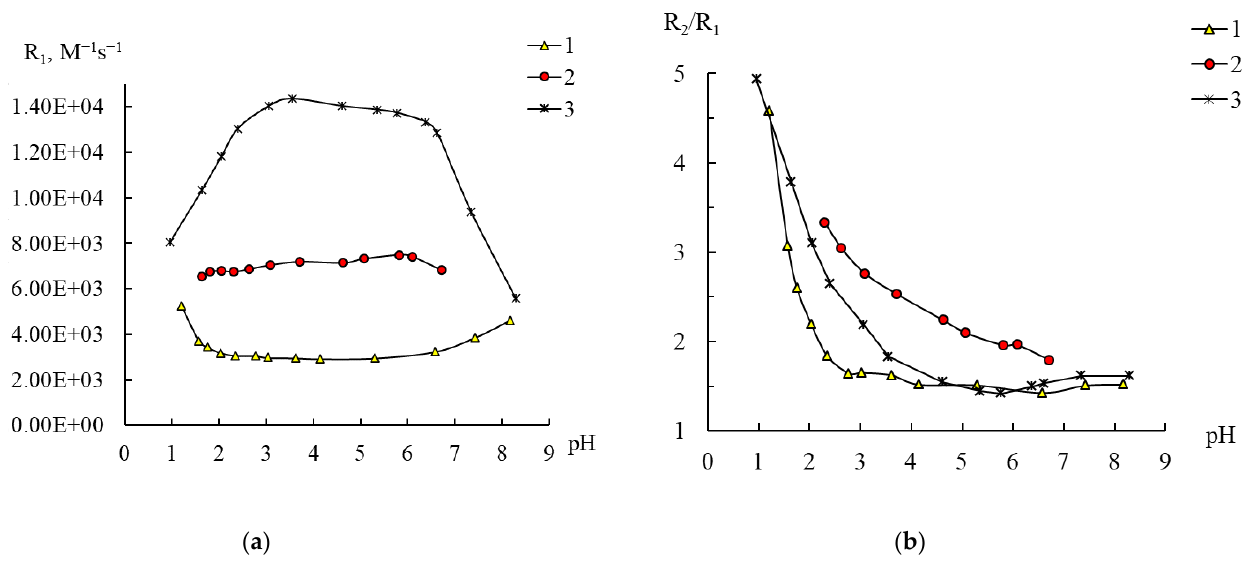
Figure 7. Changes in the relaxation efficiency R 1 ( a ) and the ratio R 2 /R 1 ( b ) on the pH of solutions of compounds 1 (0.4 mM) (1), 2 (0.133 mM) (2), and 3 (0.1 mM) (3). C Mn(II) 0.2 (3), 0.4 mM (1, 2).